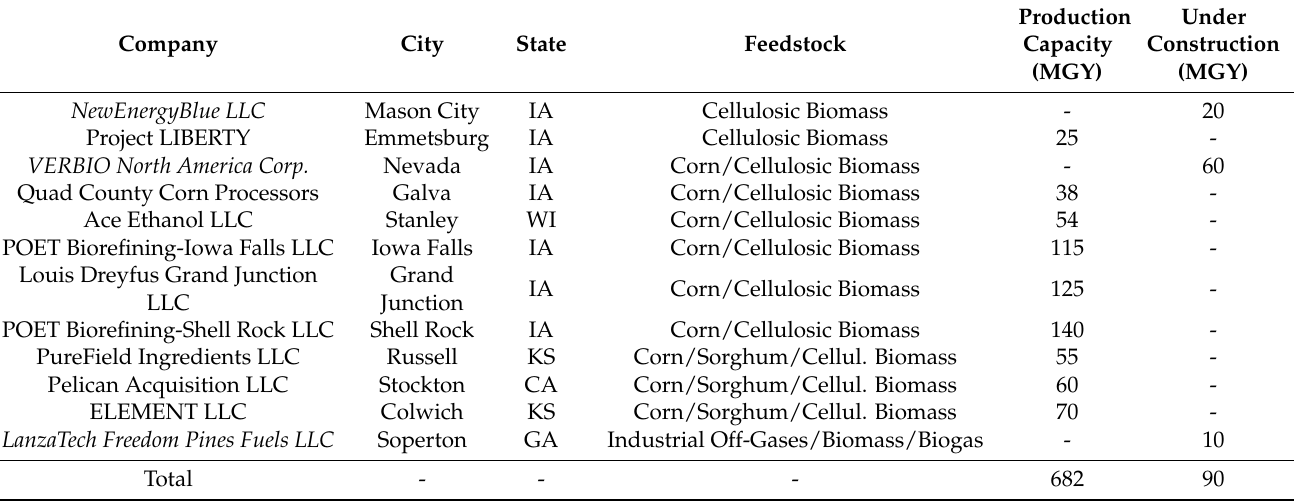
Table 3. The operational or close to operational advanced biofuel plants in the EU that produce second-generation bioethanol commercially (state as of 2022, based on [23]).